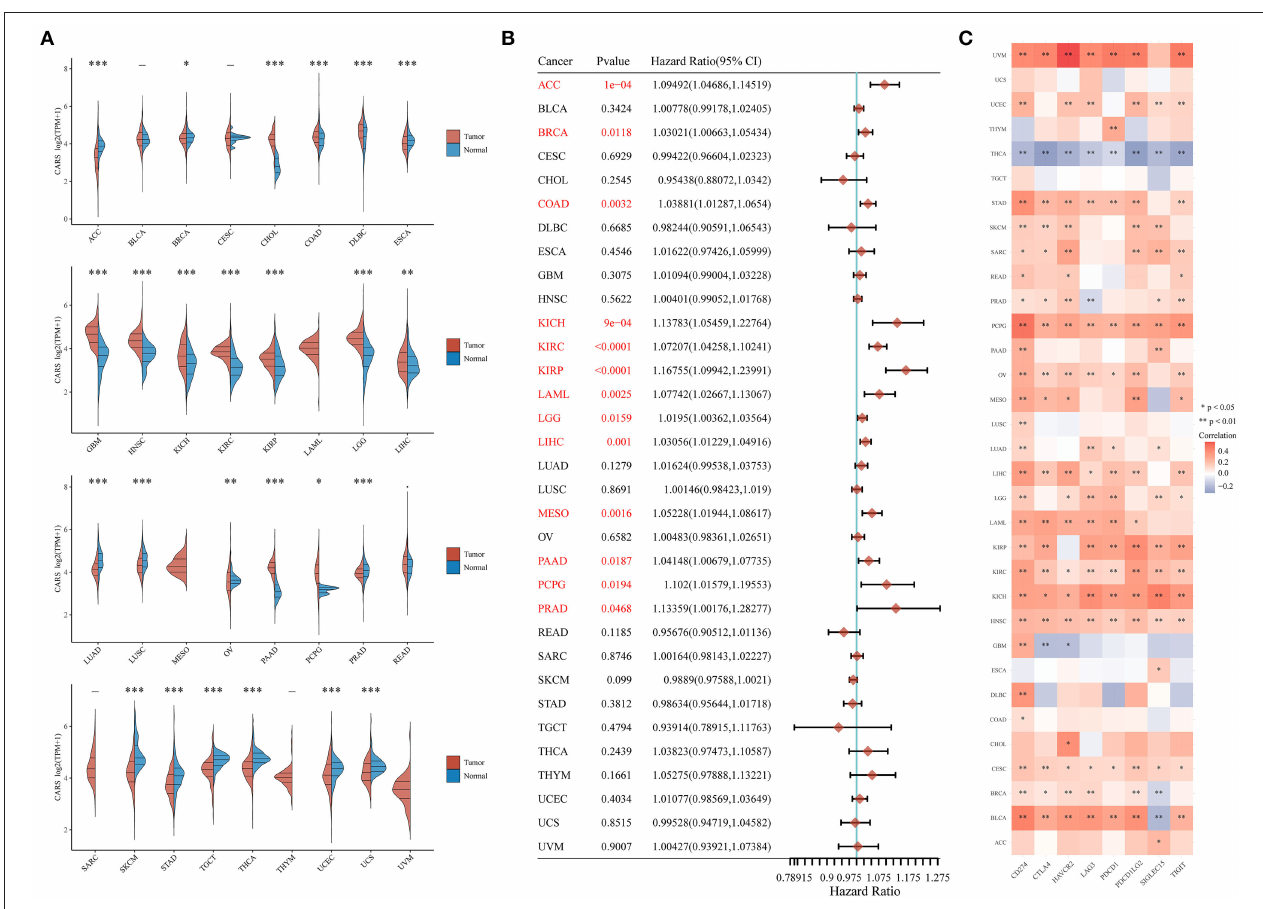
FIGURE 8 | Comprehensive analysis of key ferroptosis regulator CARS in pan-cancers. (A) CARS was differentially expressed in most cancer types. (B) Highly expressed CARS showed poor overall survival in various cancers. (C) The association of CARS expression with the expression of eight common immune checkpoints was observed in most cancer types, especially the expression level of PD-L1. * p < 0.05, ** p < 0.01, and *** p <